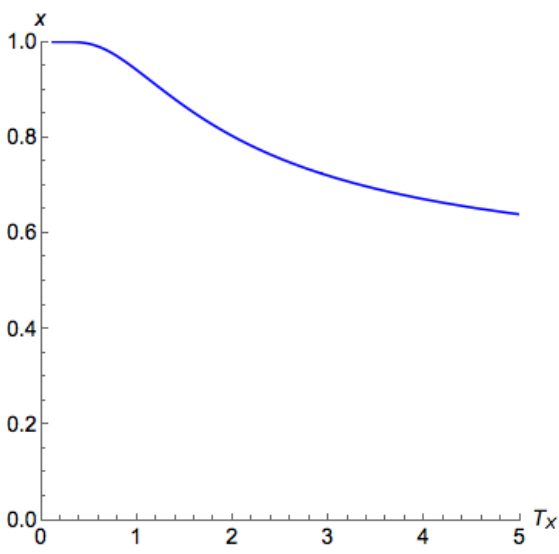
Figure A3. Bifurcation diagram for a game with one dominating strategy for the first player and a Y + b Y < 0.